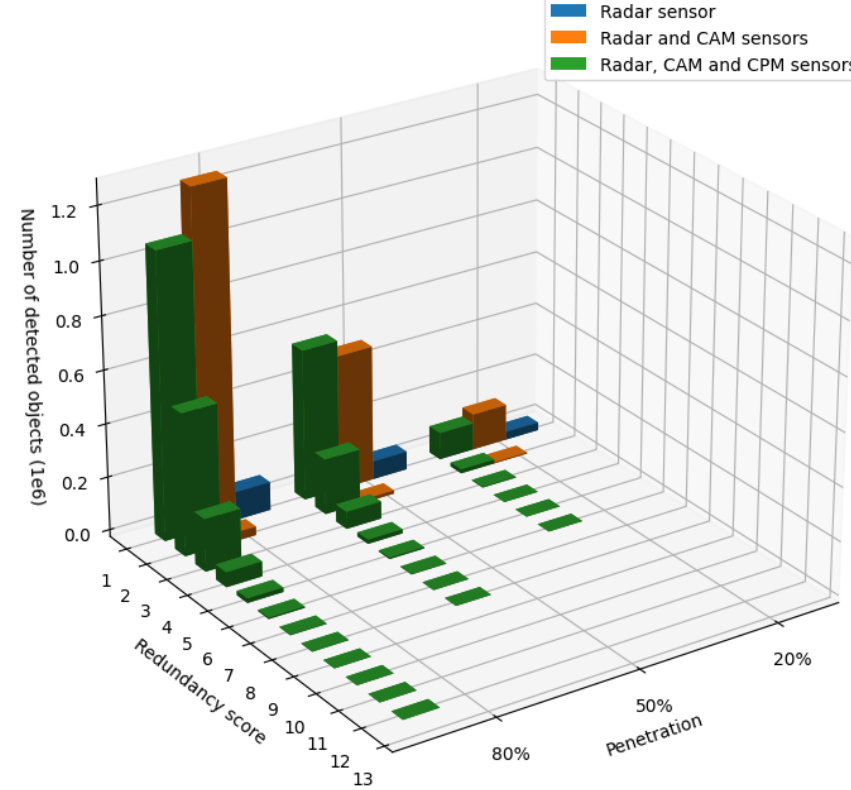
Figure 12. The redundancy score of the different